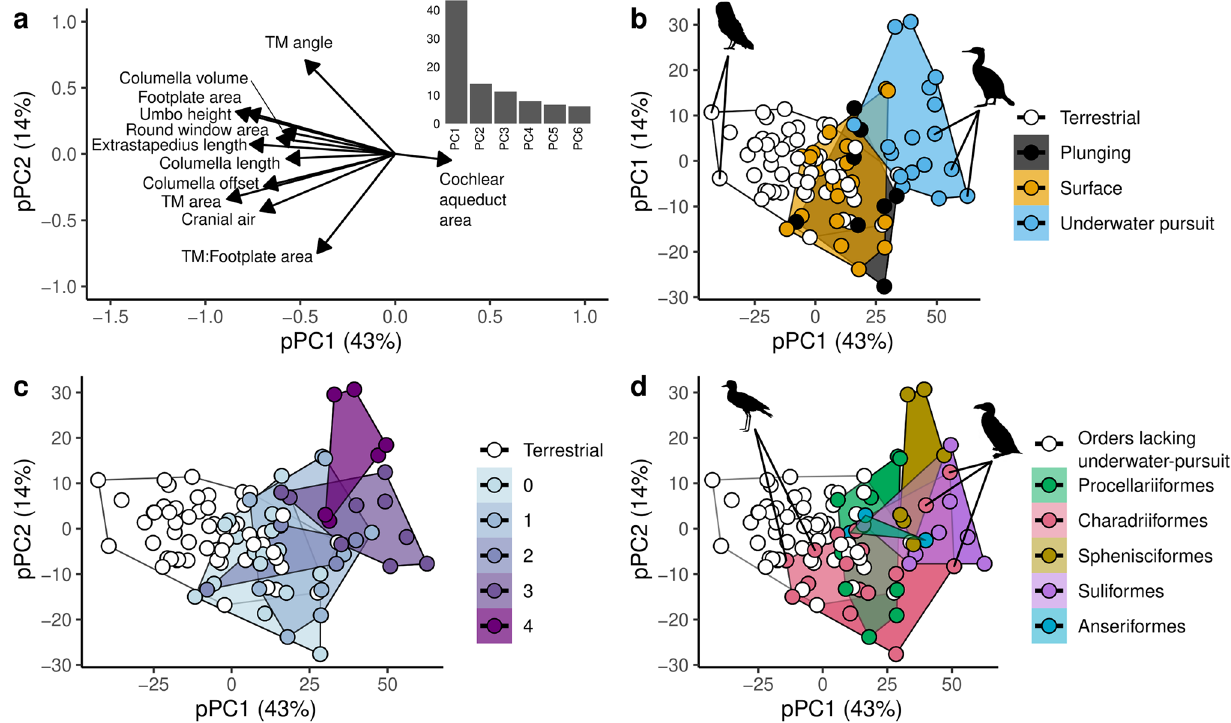
Figure 3. ( a ) Loading plots for pPC1 and pPC2 (TM stands for tympanic membrane) with inset bar plot of percent variance explained for first six principal components. ( b ) Scatterplot of pPC1 and pPC2 grouped by ecological groups. Several extreme scores are highlighted: owls ( Bubo africanus and Tyto alba ) on the negative pPC1 end and Phalacrocorax cormorants ( P. lucidus , P. capensis , P. neglectus ) on the positive pPC1 end. ( c ) Scatterplot of pPC1 and pPC2 grouped by dive score with increasing value of pPC1 indicating smaller values of most morphological measurements for a given head mass. ( d ) Scatterplot of pPC1 and pPC2 grouped by orders with at least one underwater-pursuit species. The diversity within Charadriiformes is highlighted by low pPC1 scores in two terrestrial species ( Burhinus capensis , Vanellus coronatus ) and high pPC1 scores in three diving species ( Alca torda , Fratercula arctica , Cepphus grylle ). Silhouette images provided by PhyloPic’s database (http:// phylo pic. org/), see electronic supplemental materials S8 for detailed